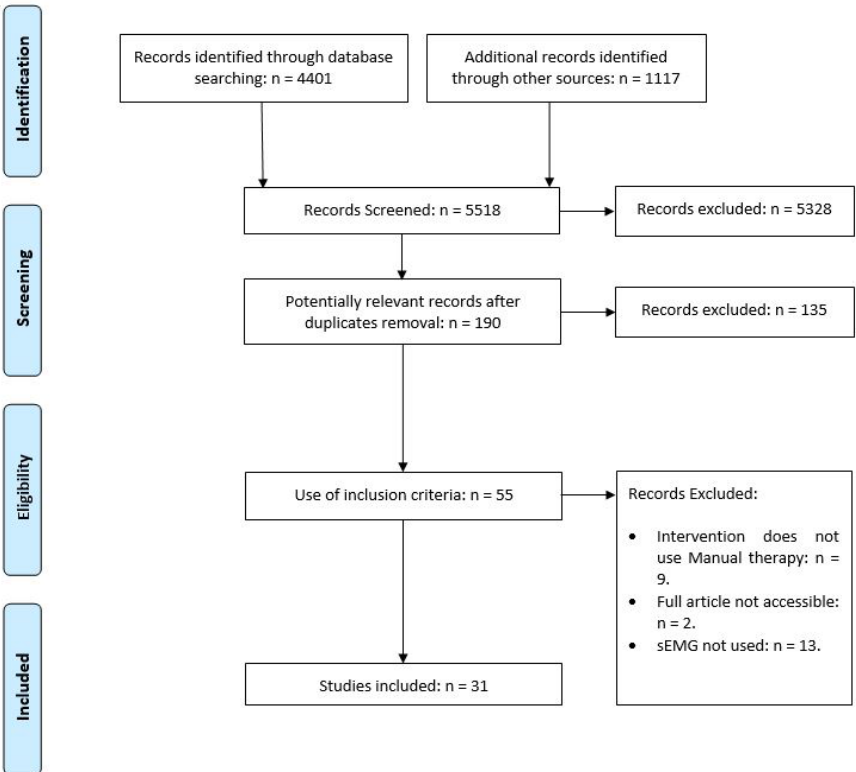
Figure 1. PRISMA statement selection criteria